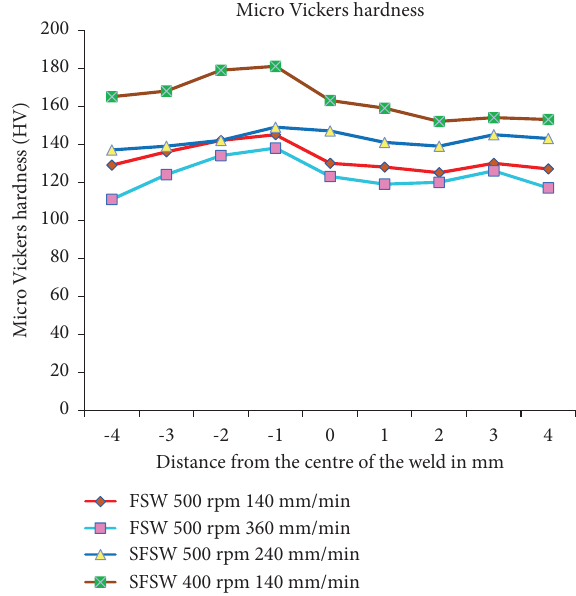
Figure 10: Micro-Vickers hardness of the welded